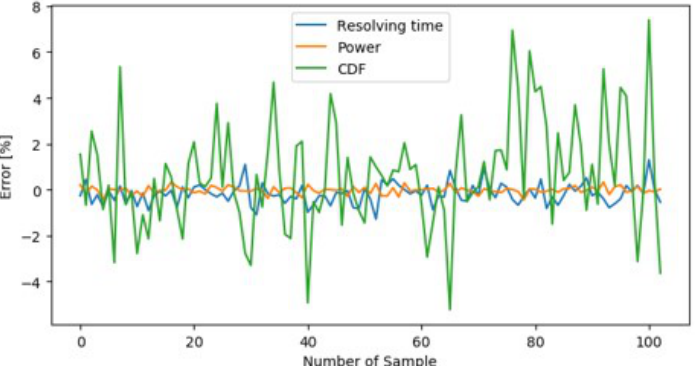
Figure 6. ANN regression accuracy of the comparator.